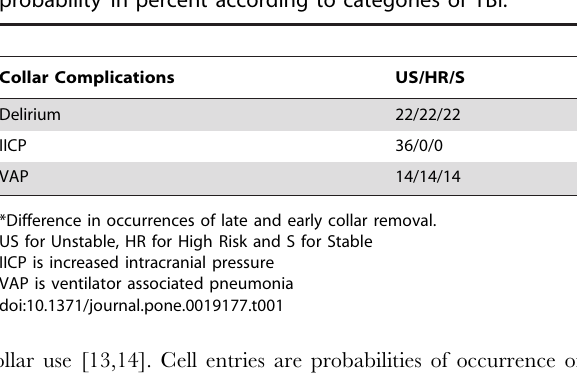
Table 1. Collar complications expressed as marginal probability*in percent according to categories of TBI.